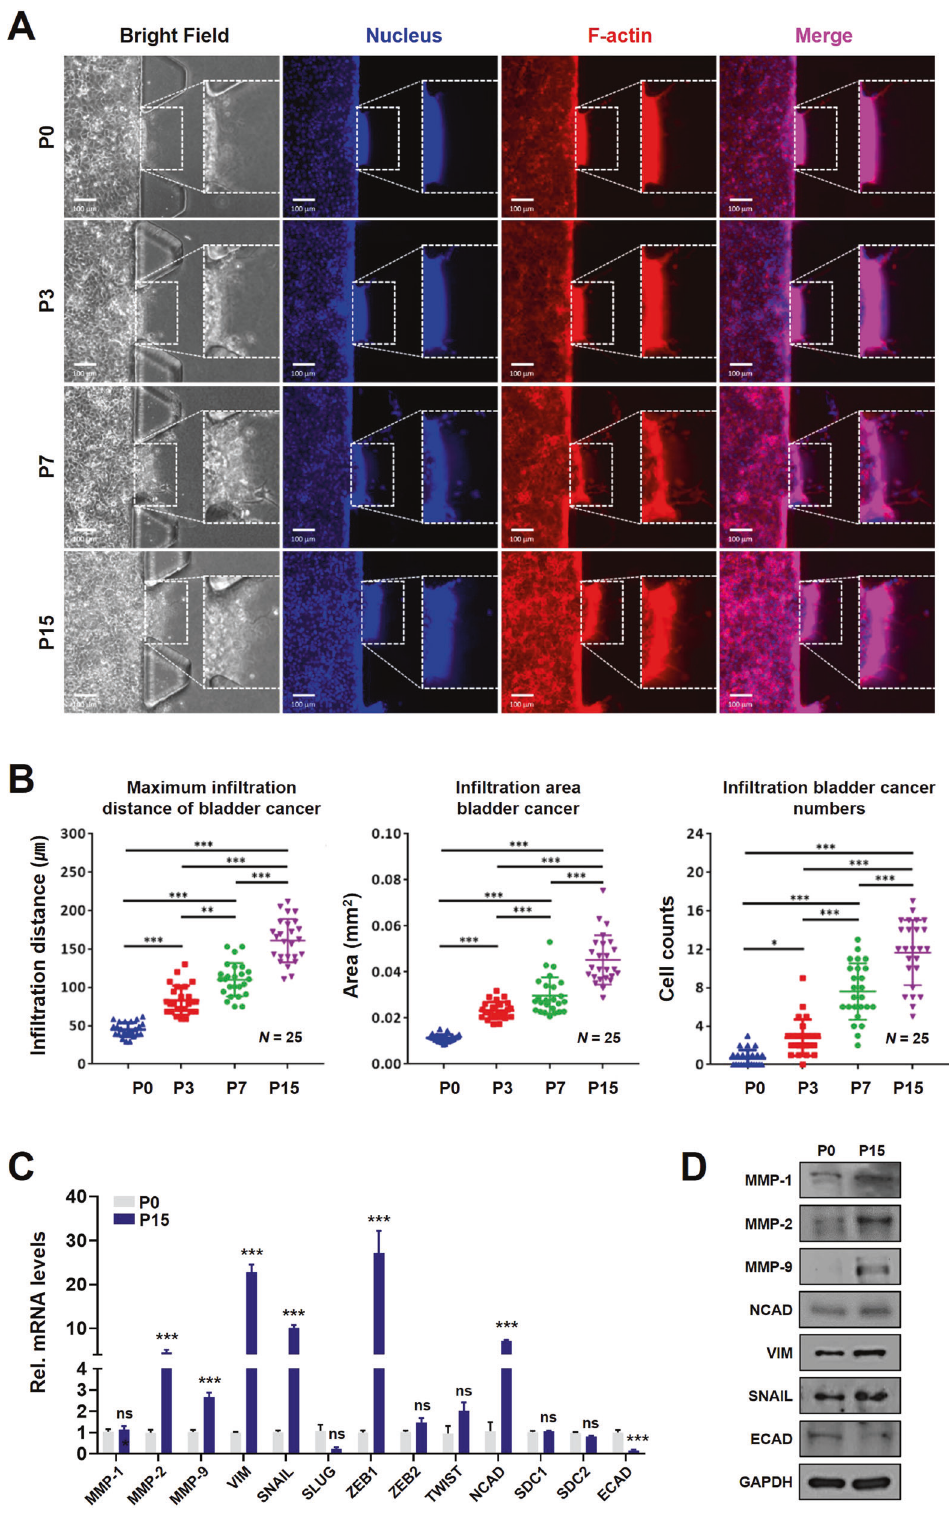
Fig. 2 Cell mobility in 3D conditions and expression of EMT-related genes in the GRC1 cell line. A Representative image of the GRC1 cell line invading the gel on a micro fl uidic device. B The results of quantitative analysis of the maximum in fi ltration distance, in fi ltration area, and in fi ltration numbers of the GRC1 cell line using ImageJ software. C Con fi rmation of the mRNA and D protein levels of EMT-related genes in parental phase P0 and late phase P15. ns not signi fi cant; * P < 0.05; *** P <